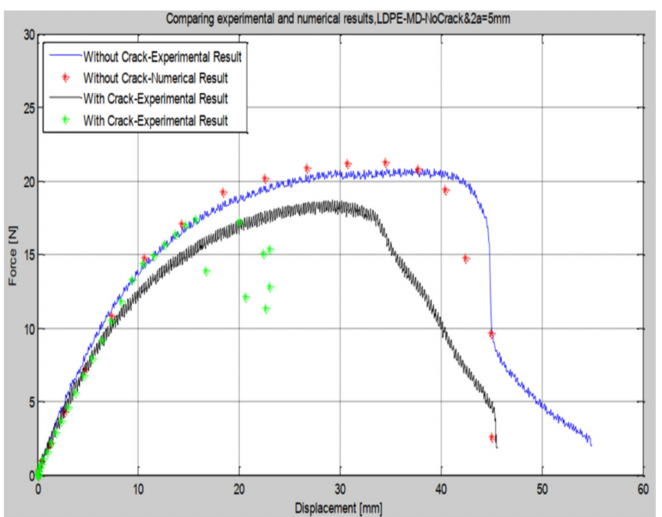
Figure 9. Response of LDPE-MD-95 230 mm experimental and numerical results with crack 2a = 5 mm and without